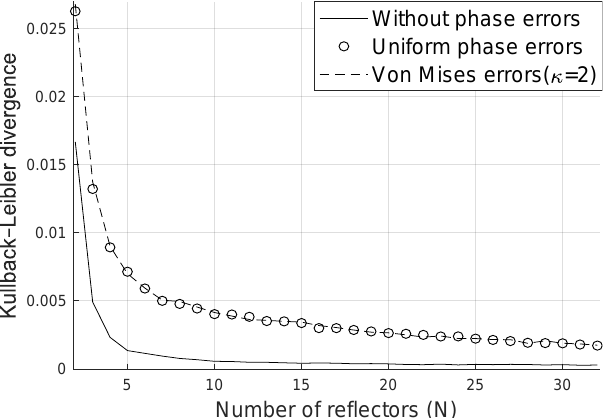
Figure 4. Kullback–Leibler divergence for the fading squared